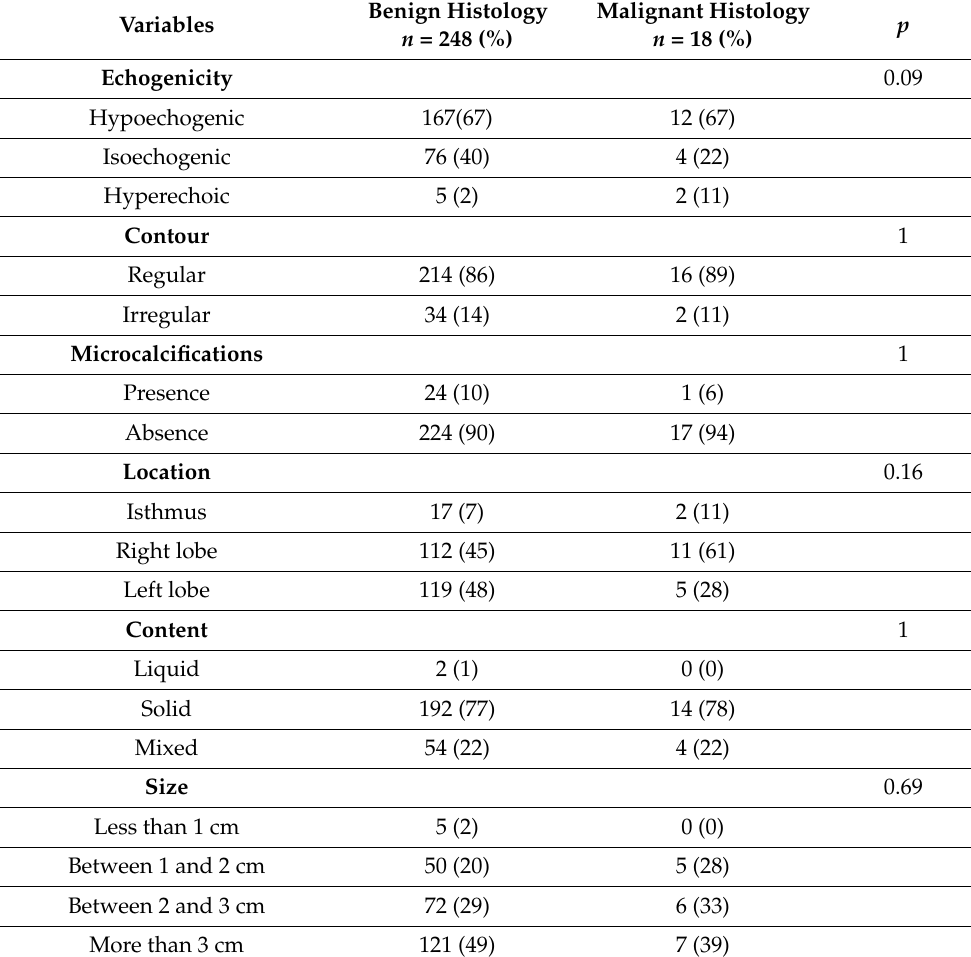
Table 2. Comparison between the main characteristics of thyroid nodules and the final histological diagnosis (benign and